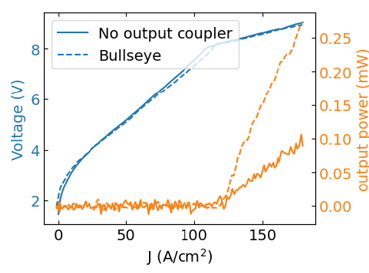
Figure 3. a) Voltage and output power as a function of current density of two devices with (solid lines) and without (dashed lines) bullseye antenna.